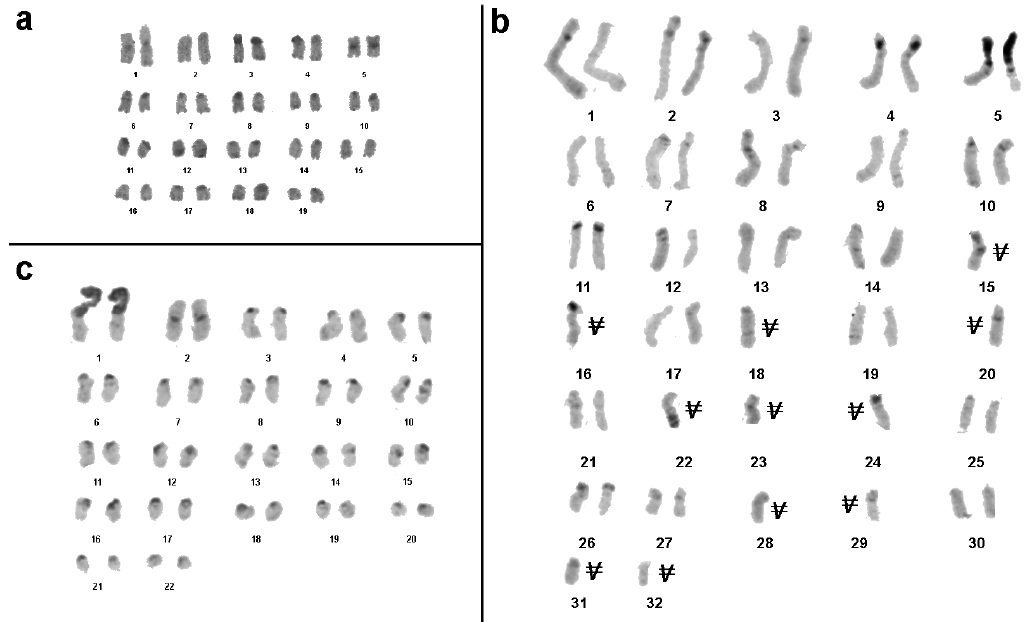
Figure 2. Karyograms from metaphase plates of female embryos of three of the studied species; gonosomes could not be identified. ( a ) Female M. extradentata have 19 chromosome pairs, i.e., most likely a karyotype 36,XX. ( b ) For female Sungaya inexpectata no complete metaphases could be obtained; here we show one incomplete metaphase with 53 chromosomes and 32 different chromosome pairs identified—lacking chromosomes are indicated by a V. Still, it is obvious that this species is diploid. ( c ) Female Sipyloidea sipylus have 22 chromosome pairs, i.e., most likely a karyotype 42,XX.